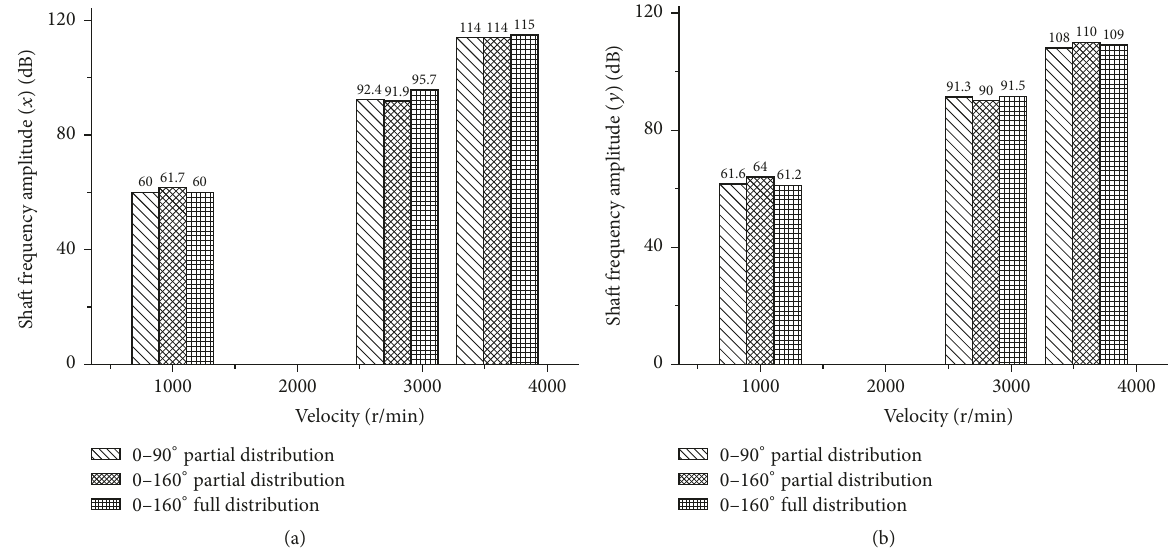
Figure 9: Shaft frequency amplitude: (a) horizontal direction; (b) vertical